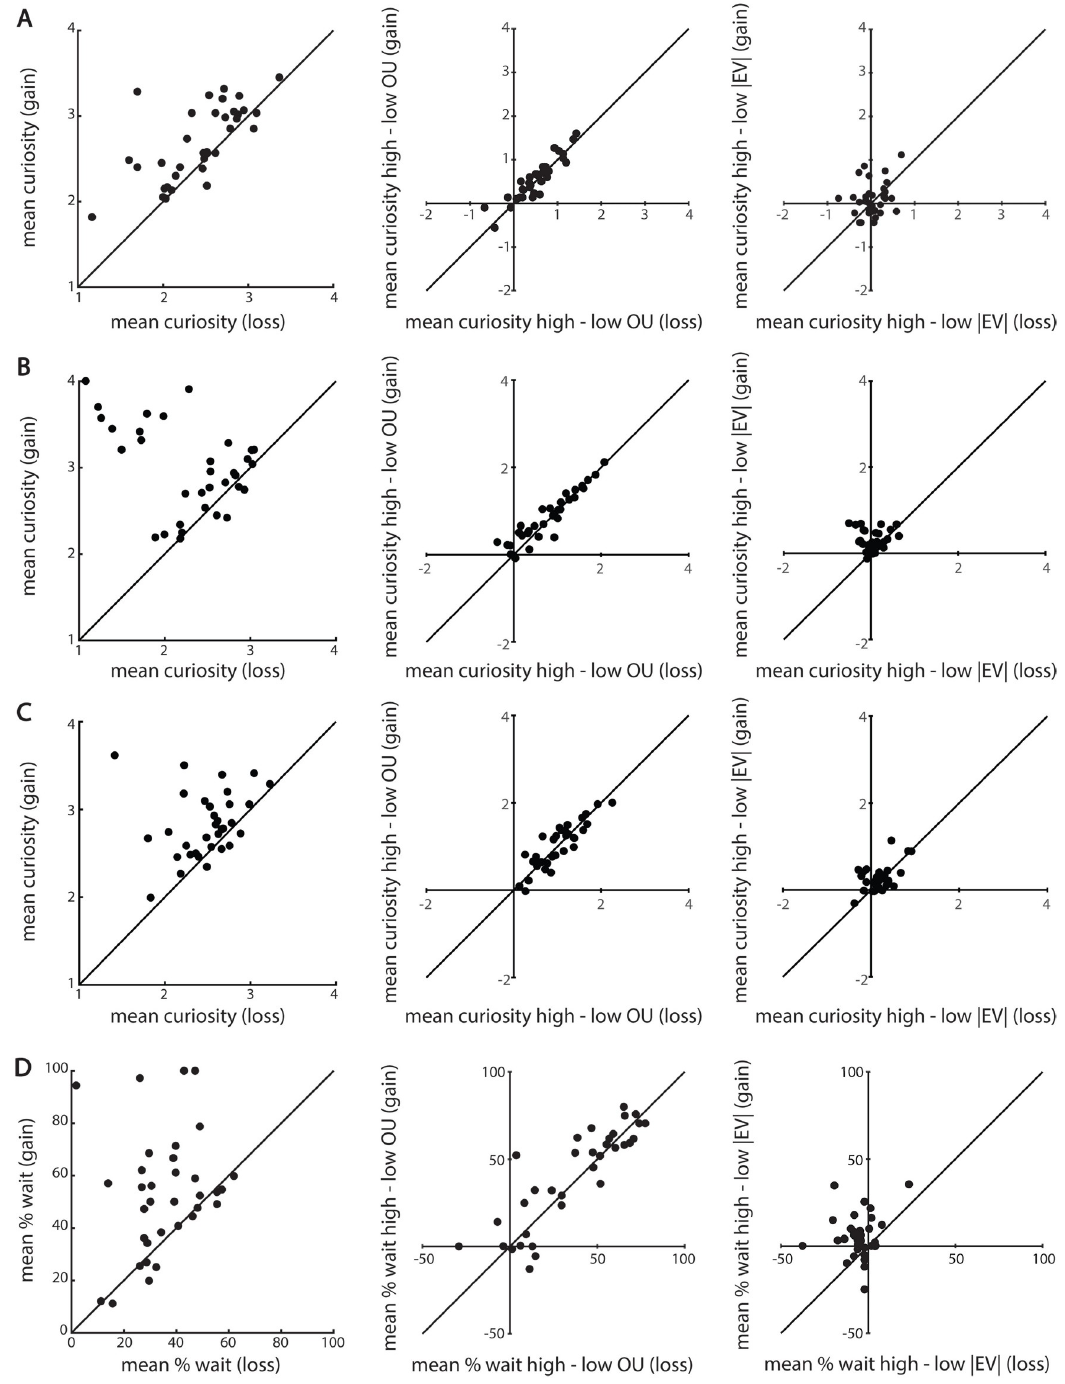
Fig 3. Individual variability of the outcome valence (gain/loss), outcome uncertainty (OU) and absolute expected value (|EV|) effects of Experiment 1A (A,B,C) and Experiment 2 (D,E,F). The left panels depict individual variability in participants’ curiosity about gains compared with losses. In all panels, the x-axis depicts the mean curiosity/willingness to wait for the loss trials and the y- axis depicts the mean curiosity/willingness to wait for gain trails. Every dot depicts one participant. In all panels, most dots are above the diagonal, indicating that a great majority of the participants were more curious ( A, B and C —left panels) and more willing to wait ( D —left panel) for gains compared with losses. The middle panels depict individual variability in the extent to which participants were driven by outcome uncertainty for gain and loss trials. In all panels, the x-axis depicts the mean curiosity/ willingness to wait for high minus low outcome uncertainty in loss trials, with positive and negative values indicating a positive